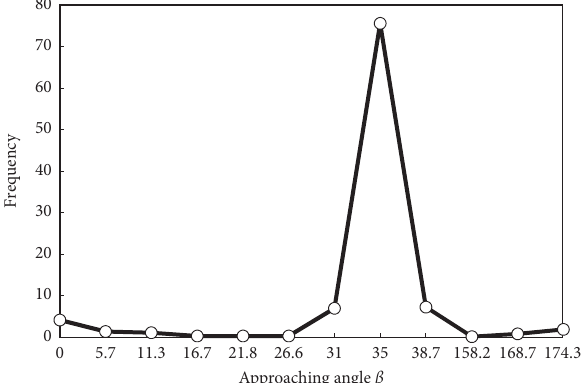
Figure 5: Approaching angle and its frequency.